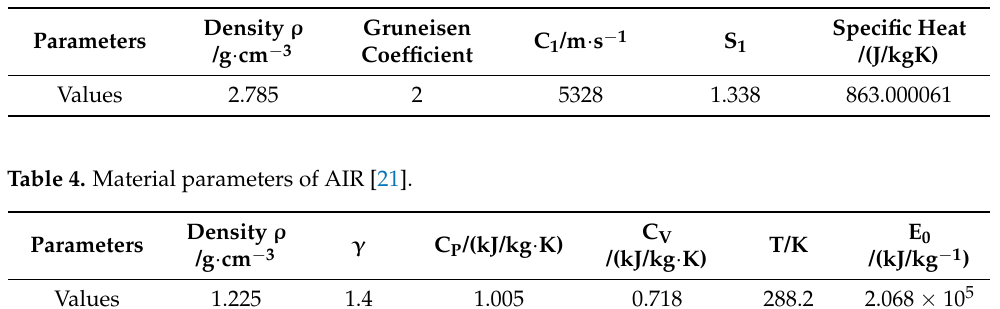
Table 2. JH-2 material parameters of ZrCuNiAlAg amorphous alloy [22].